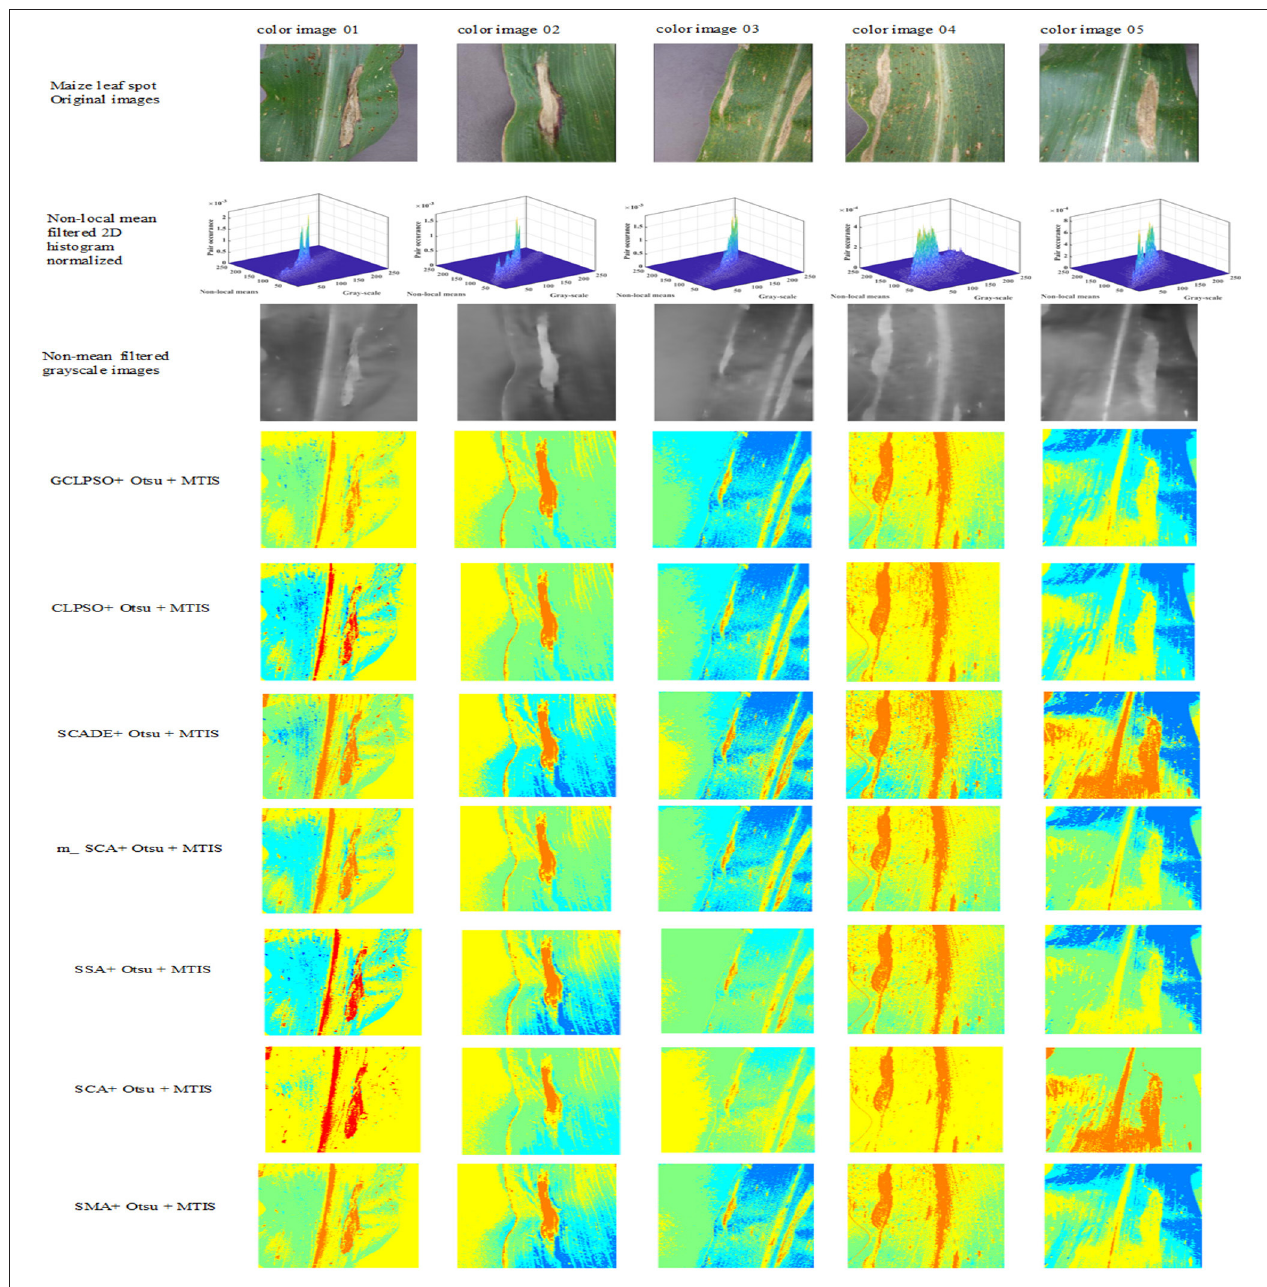
FIGURE 5 | Original images, non-local mean filtered normalized 2D histogram, non-local mean filtered grayscale image results, and four-threshold color image segmentation results of all the algorithms of maize leaf spot disease color images 1–5.